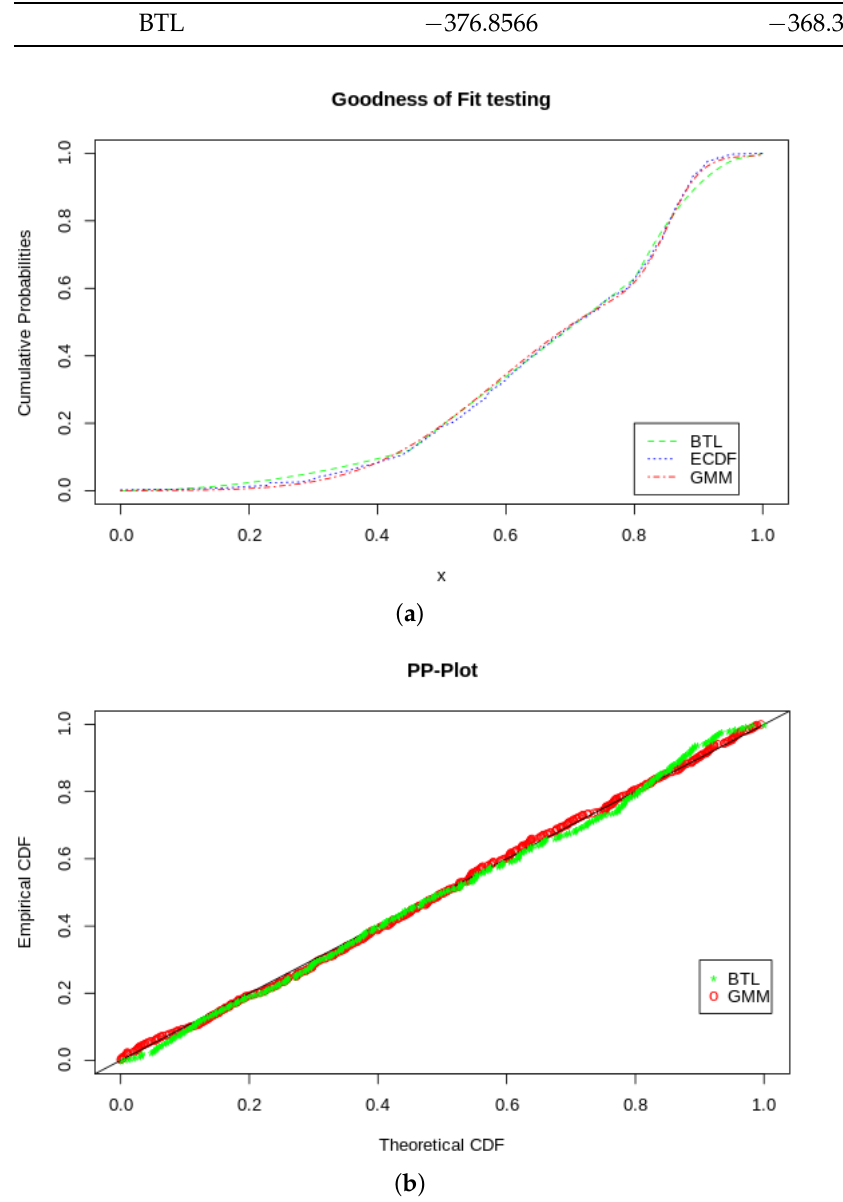
Figure 9. GOF tests. ( a ) ECDF, BTL CDF and GMM pseudo-CDF. ( b ) PP-plot of BTL and